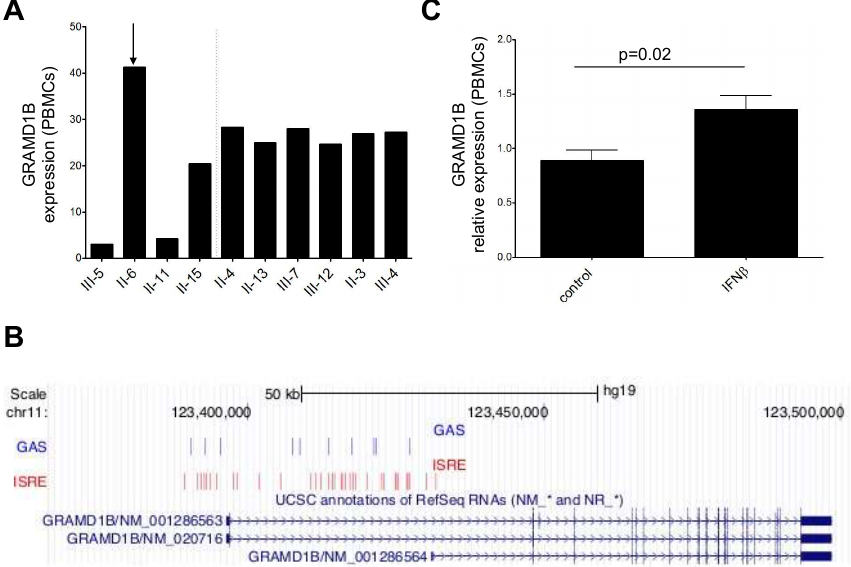
Figure 4. GRAMD1B mRNA expression in whole blood of members of the MS multiplex family, and in PBMC isolated from HC. ( A ) Relative GRAMD1B mRNA expression in whole blood from affected (on the left of the dashed line) and unaffected relatives (on the right of the dashed line) of the original MS multiplex family measured with Illumina arrays. The arrow indicates the unique MS patient who was IFN β -treated. ( B ) ISRE and GAS elements in the GRAMD1B promoter and first intron identified in the in silico analysis are shown in the “GAS” and “ISRE” tracks, while the position of the gene is indicated in the “UCSC annotation of RefSeq RNAs” track; genomic position is indicated at the top. ( C ) Relative GRAMD1B mRNA expression in PBMC isolated from HC before and after stimulation with IFN β immunomodulatory cytokine measured by qRT-PCR ( n = 5). p -value refers to the comparison of expression values at baseline and after stimulation. Standard deviations are reported as bars. Error bars represent SEM.